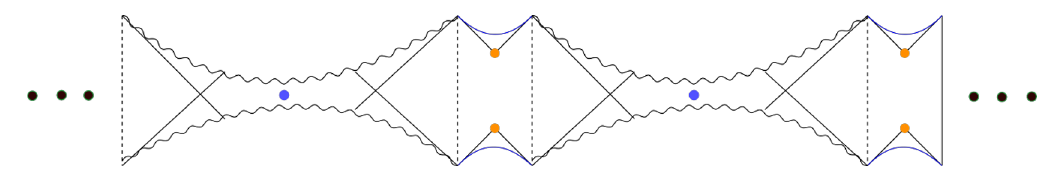
Figure 3 . The universal covering space of the Penrose diagram of the backreacted black hole. Black dots indicate that we can continue this pattern